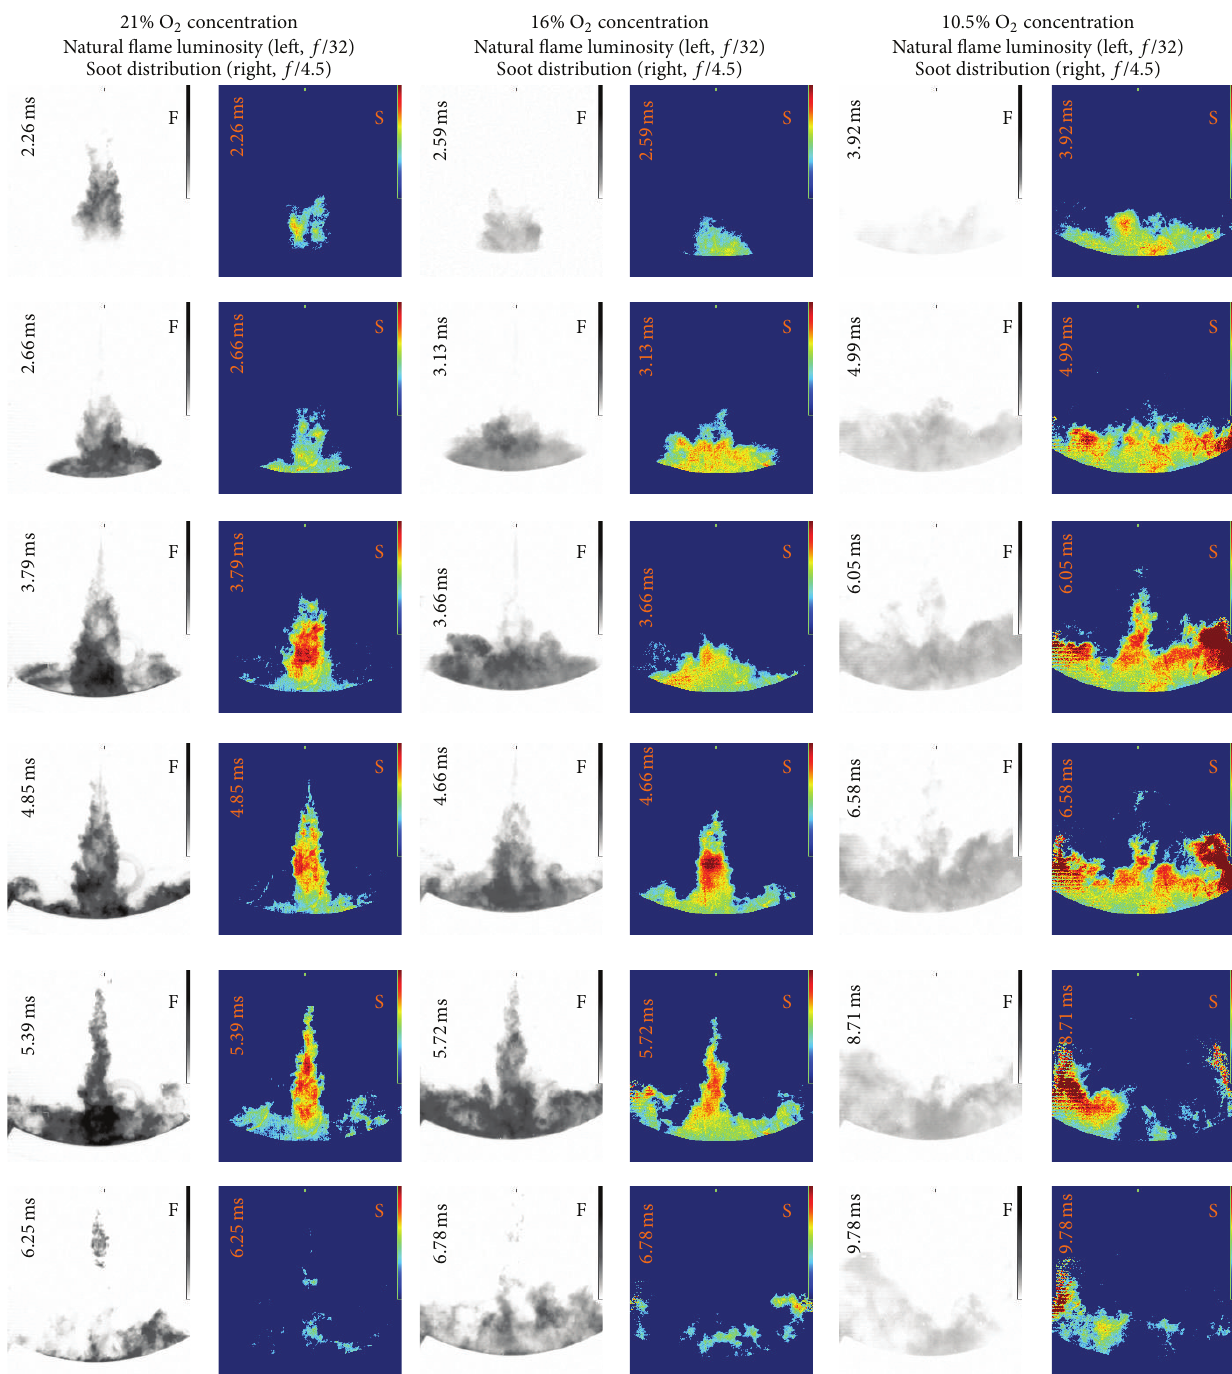
Figure 13: Natural flame luminosity and soot distribution for soybean biodiesel at 1000 K ambient temperature [68].